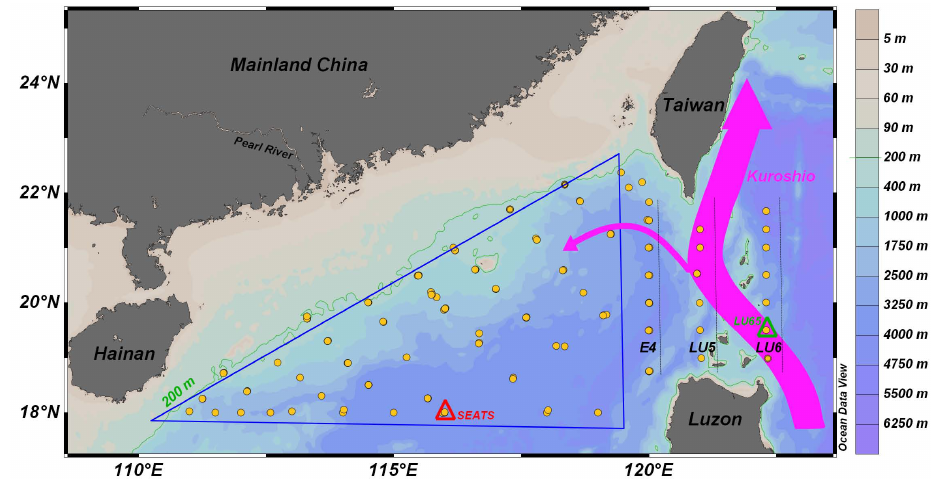
Fig. 1. Map of the northern South China Sea (NSCS) showing its topography and the locations of the sampling stations (yellow dots). The blue triangle indicates the focused region in which the nutrient inventory was assessed. Three meridional sections across the Luzon Strait are highlighted with dark dotted lines (i.e., sections E4, LU5 and LU6, among which sections LU5 and LU6 were investigated only in spring 2011). Also shown schematically are the Kuroshio Current and its intrusion path into the NSCS around the Luzon Strait (pink lines). The South East Asian Time-series Study (SEATS) station (red triangle) is established in the central basin of the SCS, while station LU65 (green triangle) is located in the Kuroshio travel